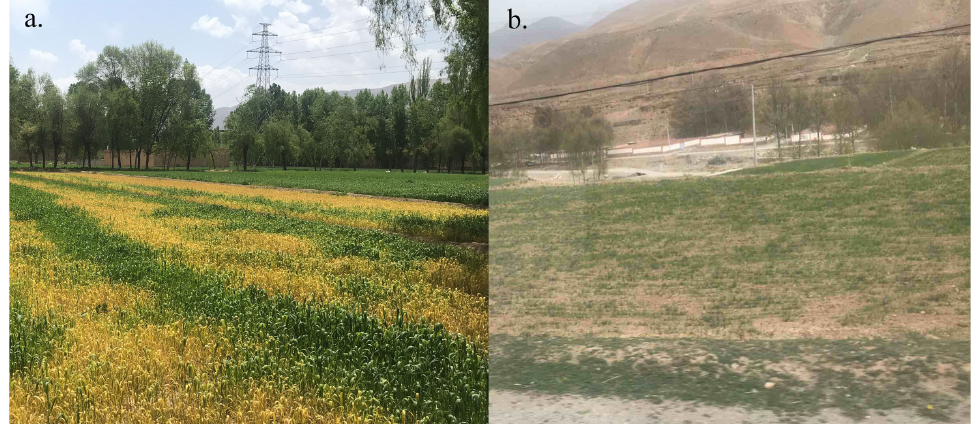
Figure 13. Winter wheat in quadrat 1 and its nearby areas which died of disease. ( a ) Winter wheat die-off in the jointing stage; ( b ) Some of winter wheat failed to overwinter. (picture taken on 2 May 2021)